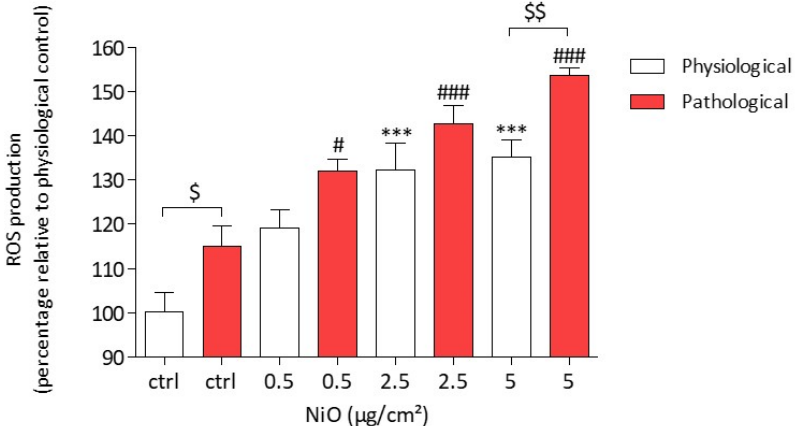
Figure 2. ROS production in HPAEC after a 4 h exposure to NiONPs (0.5–5 µ g/cm 2 ) under physiolog- ical and pathological conditions, as measured by spectrofluorimetry with the CMH 2 DCF-DA probe. The results were expressed as the percentage of CMH 2 DCF probe fluorescence intensity relative to physiological controls. Data were mean ± SEM of three independent experiments ( n = 3) performed in quadruplicate. *** p < 0.001 vs. untreated cells in 0% CS in normoxic conditions. # p < 0.05 and ### p < 0.001 vs. untreated cells in pathological conditions. $ p < 0.05 and $$ p < 0.01 between both conditions. According to Kruskal–Wallis test followed by a Dunn’s multiple comparison test.